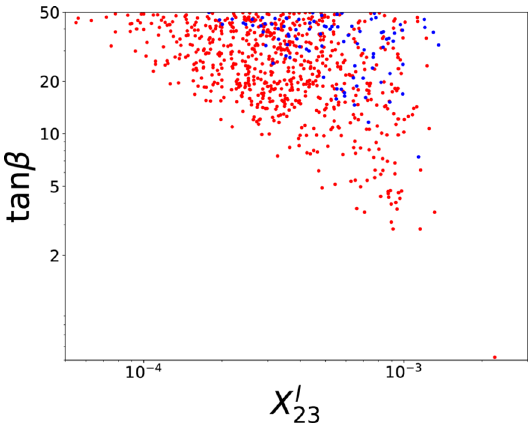
Figure 9 . The allowed parameter region satisfying the LFV constraints and muon g − 2 value within 1 × 10 − 10 < ∆ a µ < 50 × 10 − 10 for X l within 2 σ level.